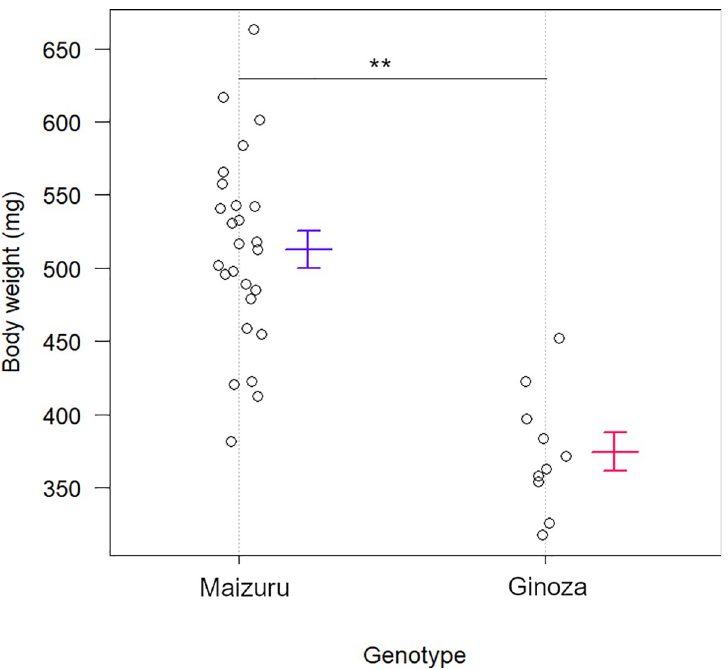
Fig 1. Mean body weight of Maizuru (n = 26) and Ginoza (n = 10). Data are shown as the means and standard errors (SE). Body weight was significantly higher in Maizuru than in Ginoza stock (512.6 vs. 374.7 mg; �� p < 0.01; Student t -